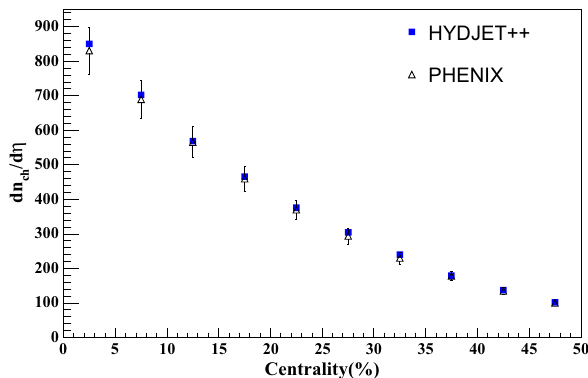
Fig. 14 Variation of dn ch / d η at midrapidity with centrality in minimum-bias configuration of U + U collisions. Experimental data